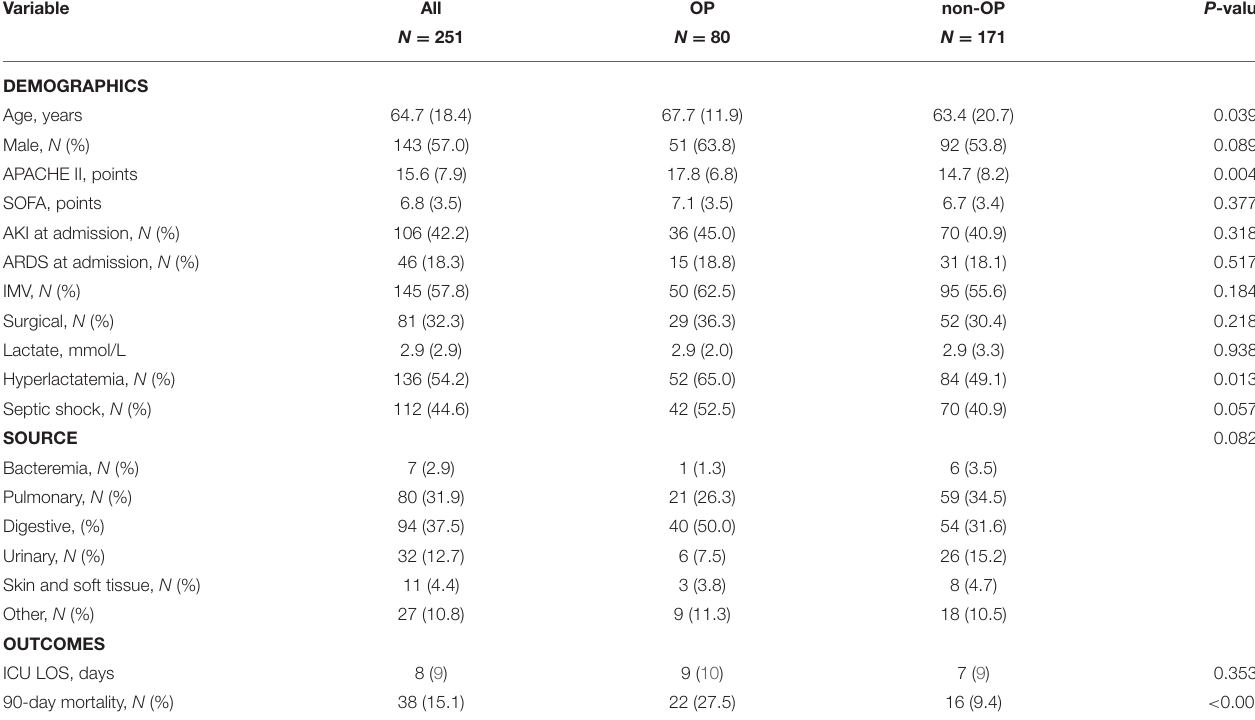
TABLE 1 | Patients’ characterization according to oncological or non-oncological status.